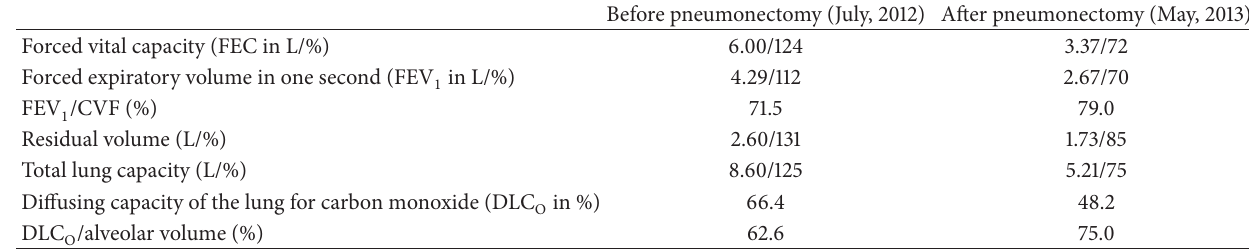
Table 1: Lung function test before and after